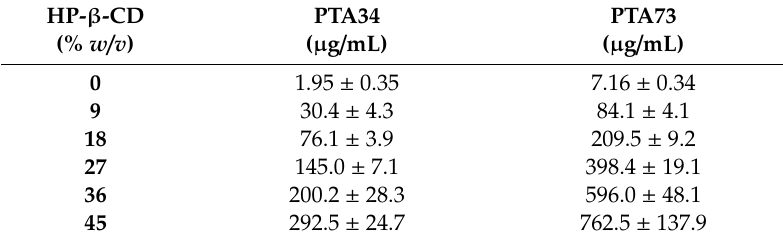
Data are the means of at least three determinations.